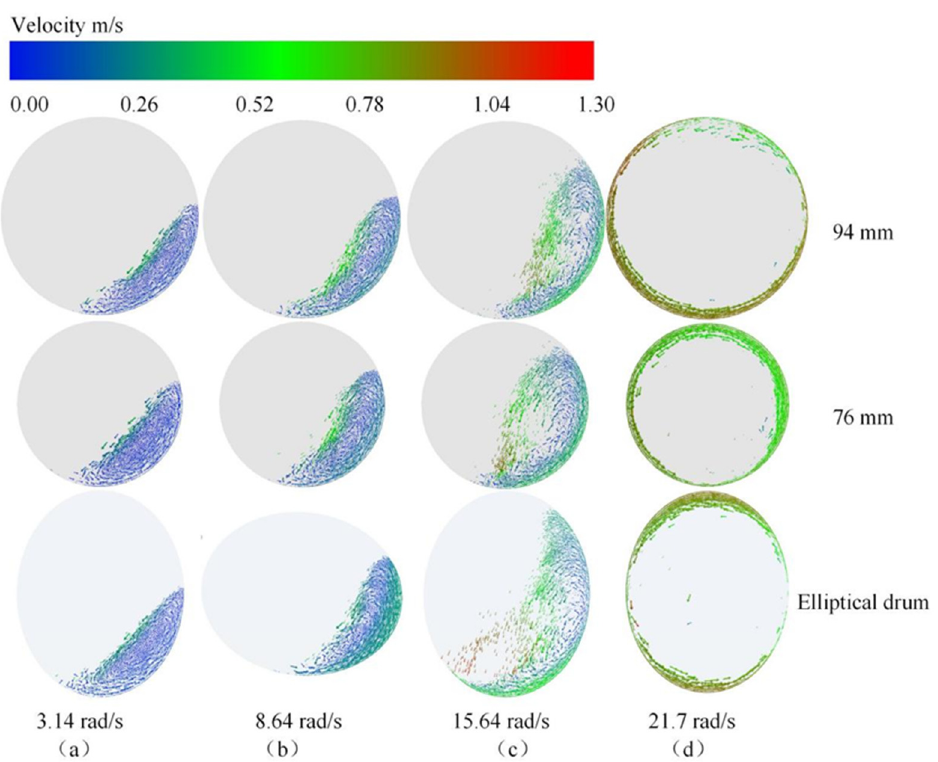
Figure 5. Vector of particle velocity within three rotating drums at different rotational speeds. (Color represents particle velocity. Red indicates fastest particles, blue indicates slowest particles, and green indicates particles traveling at medium speed, with the velocity values of the references to color in the figure legend.).